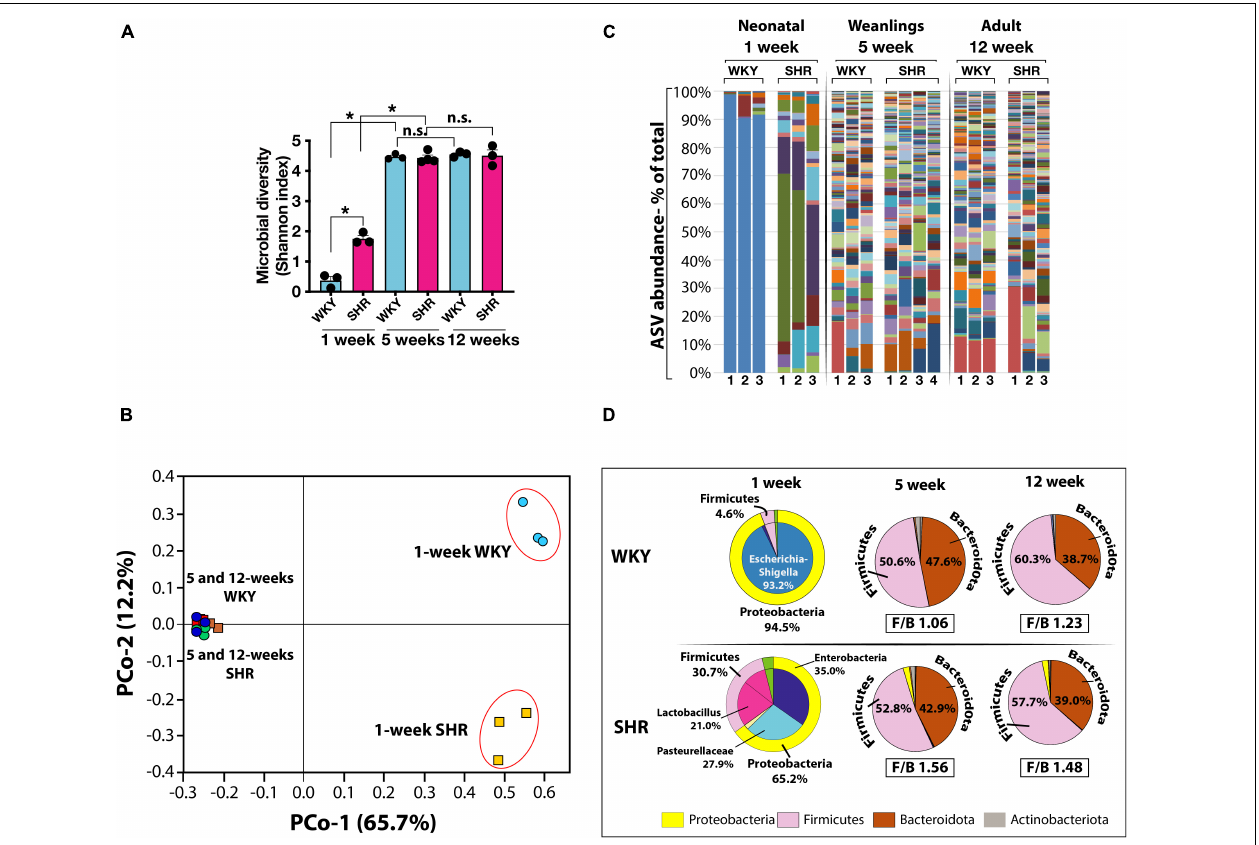
FIGURE 1 | (A) Microbial diversity (Shannon Index) and complexity are significantly greater in weanling (5-weeks old) and adult (12-weeks old) WKY (blue bars) and SHR (red bars) compared to neonatal (1-week old) rats. ( n = 3 each group except n = 4 in 5-weeks old SHR). Asterisks indicate significant difference (* P < 0.0001). (B) Principal component (PCo) analysis of clustering of microbiotas is also very different in neonatal 1-week old than older rats (PCo1, x -axis) and between 1-week old WKY and SHR (PCo2, y -axis). (C) Graphical display of major ASV (Amplicon Sequence Variants) in WKY and SHR from 1-week ( n = 3 each), 5-weeks (WKY n = 3, SHR n = 4) and 12-weeks old ( n = 3 each) rats. Different taxa are displayed in different colors and the height of each colored bar represents the population size (percent of total population). Each lane represents one sample from a mouse. (D) Pie charts display the major phyla and constituent ASV at different ages in WKY and SHR ( n = 3 in each group except n = 4 in 5-weeks old SHR). Corresponding Firmicutes to Bacteroidota ratio (F/B ratio) are shown for 5- and 12- weeks old rats. F/B ratios for 1-week old rats were not calculated due to extremely low content of Bacteroidota